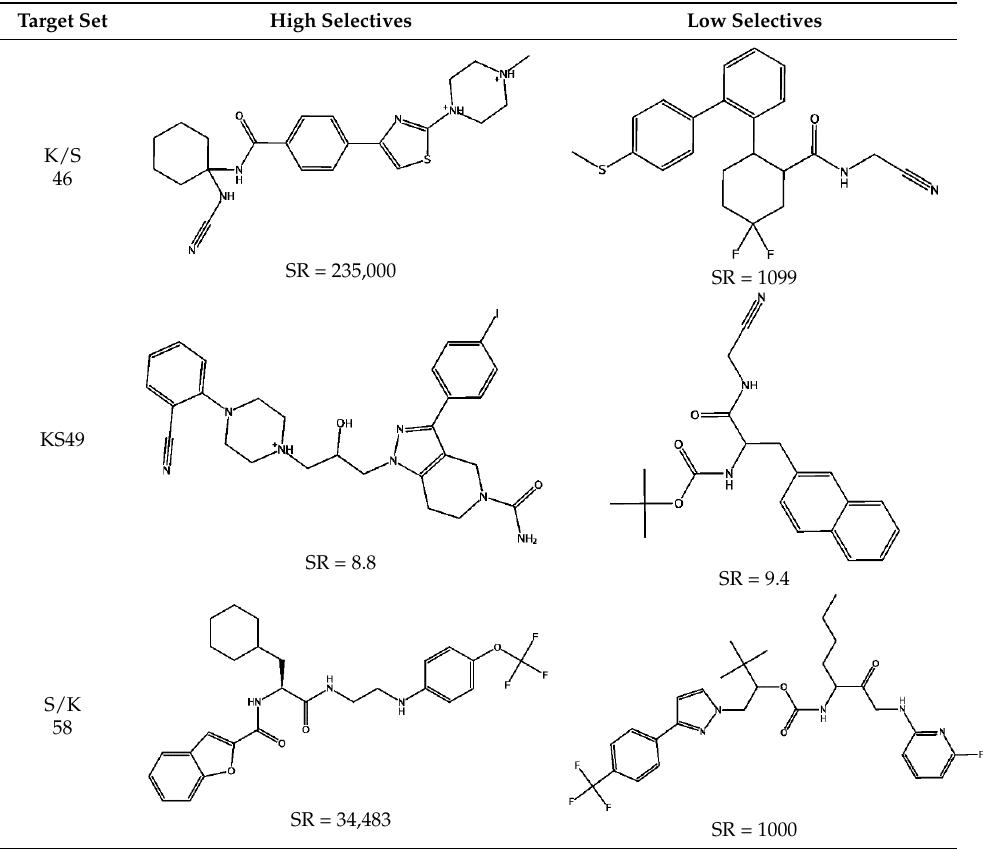
Table 1. Full description of the selectivity database of cathepsin targets K and